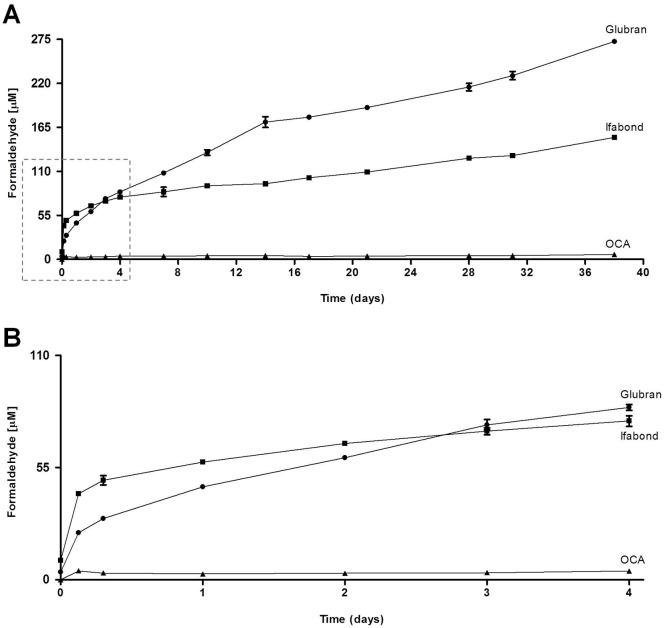
Release of formaldehyde.(A) Cumulative formaldehyde released [μM] by the different CAs used in the study (Glubran, Ifabond and OCA) after incubation in phosphate-buffered saline (PBS pH 7.4) at 37°C in a closed environment at the predetermined time points (0, 3, 6, and 24 hours and 2, 3, 4, 7, 10, 14, 17, 21, 28, 31, and 38 days). The test was performed using a fluorometric detection kit, following the manufacturer’s instructions (Assay Designs, Ann Arbor, MI). The results for each sample were averaged (n = 3). (B) Enlargement of the zone indicated with the dashed line box in A, for optimal analysis of the values of cumulative formaldehyde released [μM] by the different CAs in the initial rising phase before 4 days.